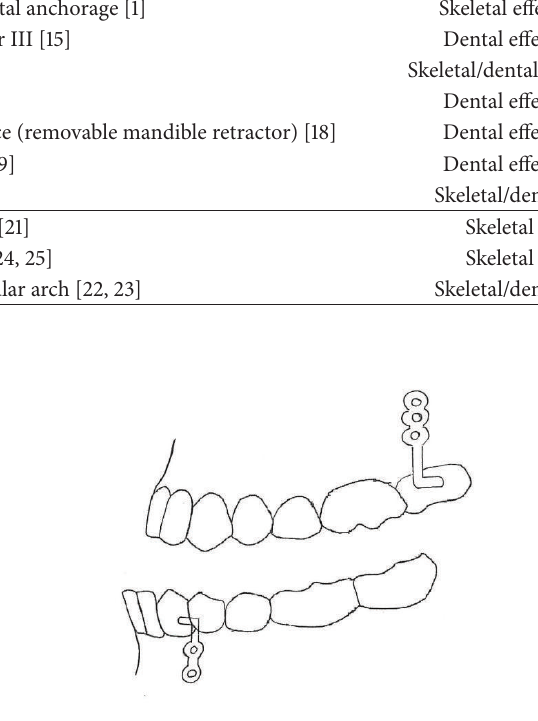
Figure 1: Class III elastic with skeletal anchorage.